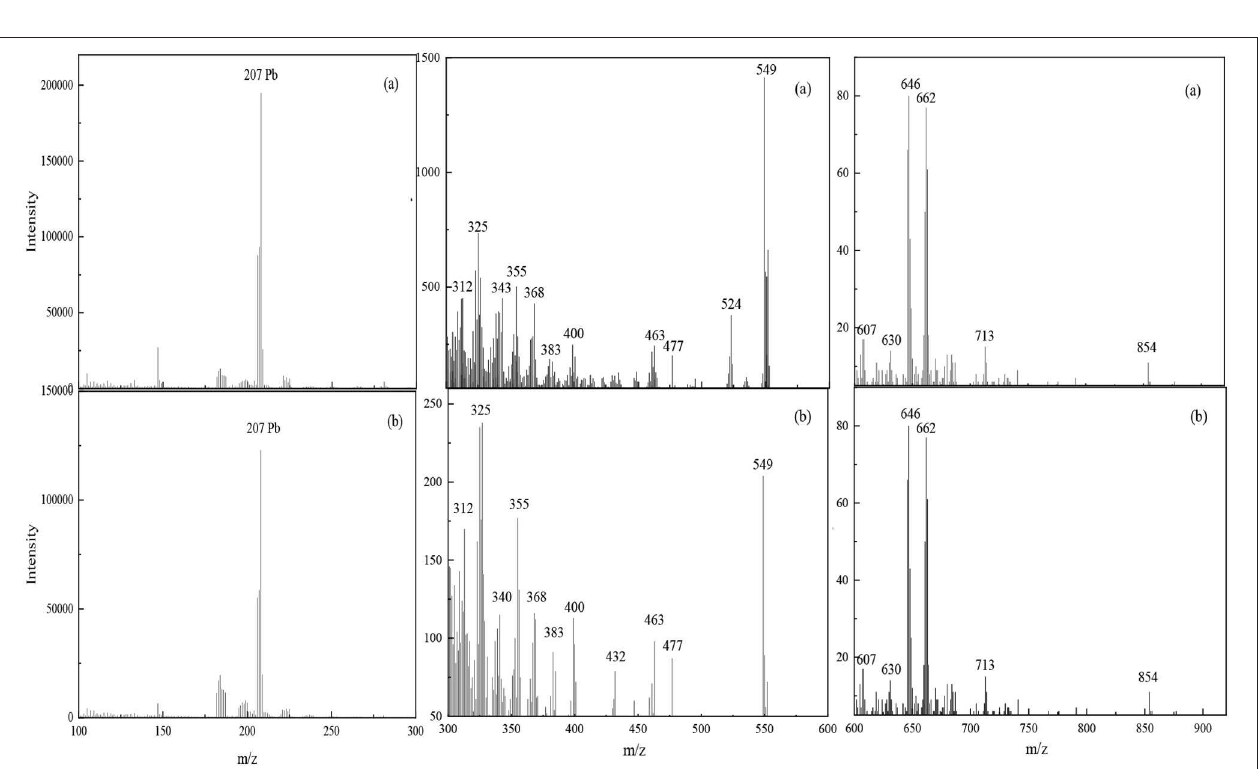
FIGURE 8 | TOF results for Pb-BHA complexes adsorbed on scheelite surface. (a) Scheelite treated with Pb 2 + and BHA sequentially; (b) scheelite treated with Pb-BHA complexes.